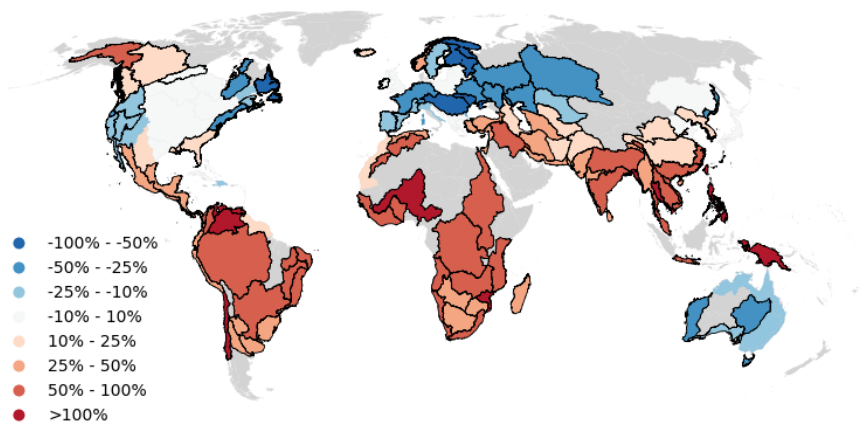
Figure 12. Linear trends in annual water withdrawal between 1984–2010 (gray shade: no reservoir data; black outlines: trend significant at p < 0 . 05). Note that the magnitude of withdrawals varies strongly between basins. Table 2. Comparison of trends in reservoir storage reconstruction against climate variability and human activities. Drivers Reservoir storage Trend (number of basins) Significant Significant Increase Decrease increase decrease Water withdrawal Significant increase (78) 18 9 36 42 Significant decrease (29) 6 6 17 Increase (93) 21 10 43 50 Decrease (41) 10 23 Climate Significant increase (23) 11 0 21 2 (precipitation Significant decrease (14) 2 4 5 9 and inflow) Increase (70) 31 Decrease